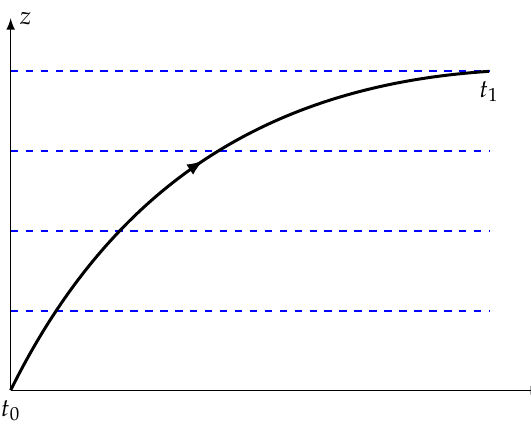
Figure 2. Approximation to the trajectory of a rocket by homogeneous altitude